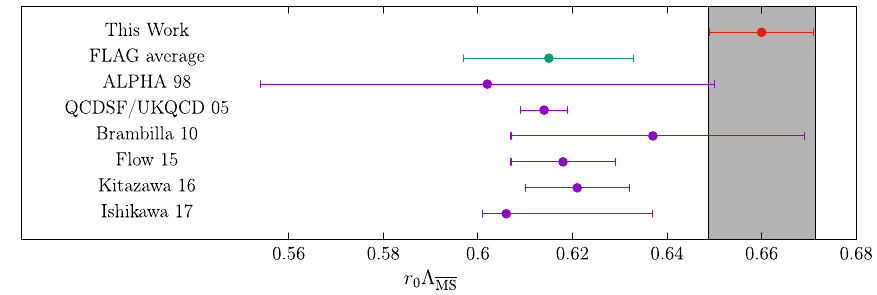
Fig. 11 Separate contributions to the square error of Eq. (5.1). Most of the error comes from the simulations on the largest lattices. The effect of the systematic uncertainty associated with O ( a )